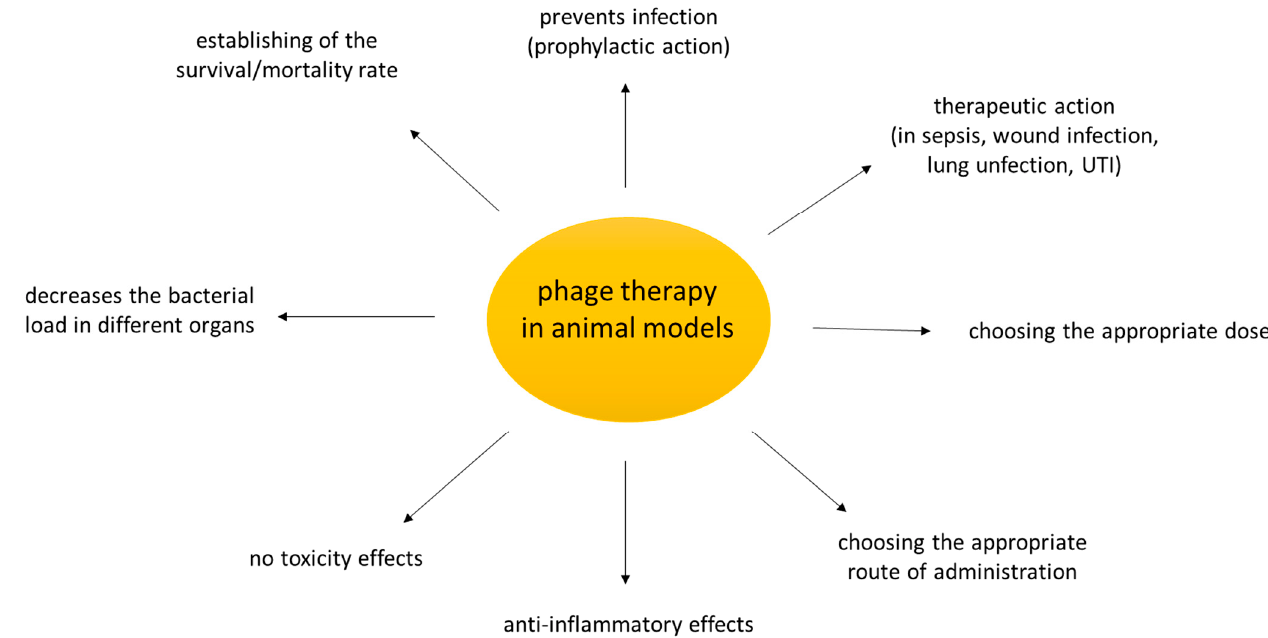
Figure 1. What could we learn from phage studies in animal models? Based on the research cited in the review.